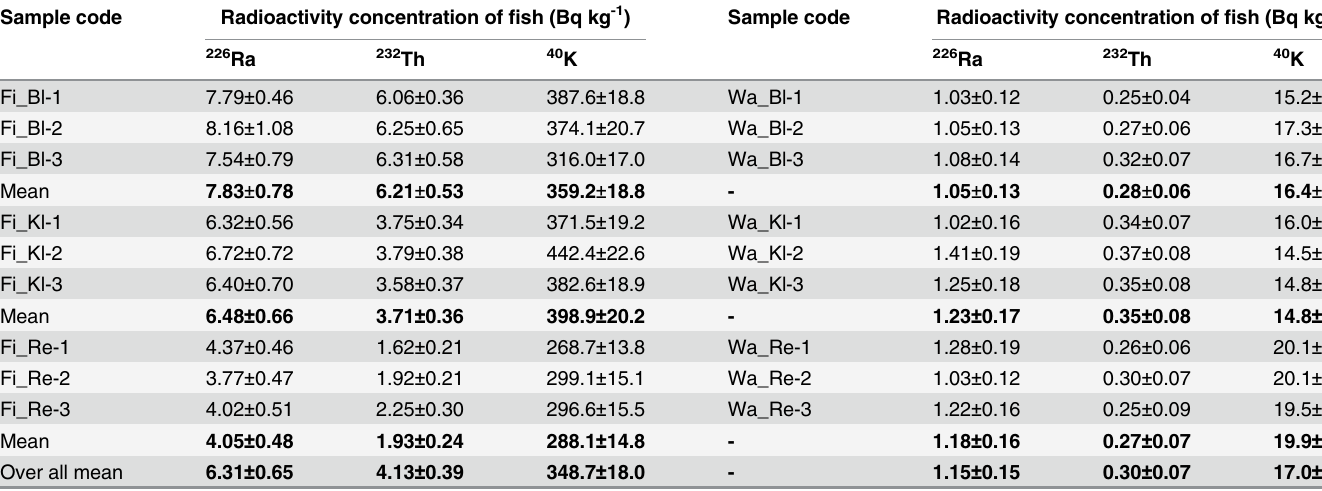
Table 3. Activity concentration (Bq kg – 1 ) of 226 Ra, 232 Th and 40 K in marine fish and water in the Strait sof Malacca. Sample code